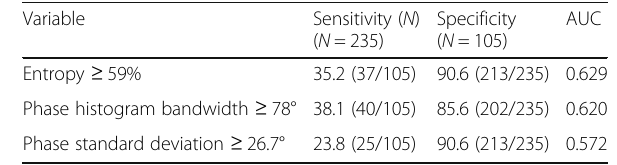
Table 4 Derivation cohort — phase variables sensitivity and